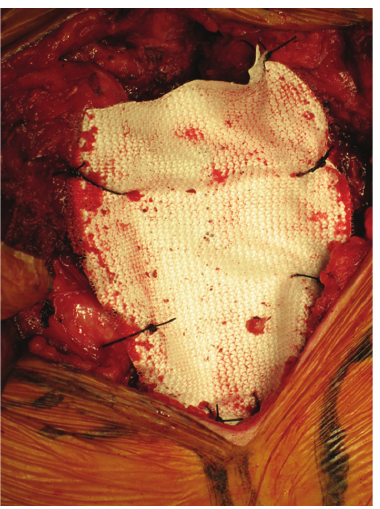
Figure 3: Repair of the sternal defect using a polypropylene/ePTFE